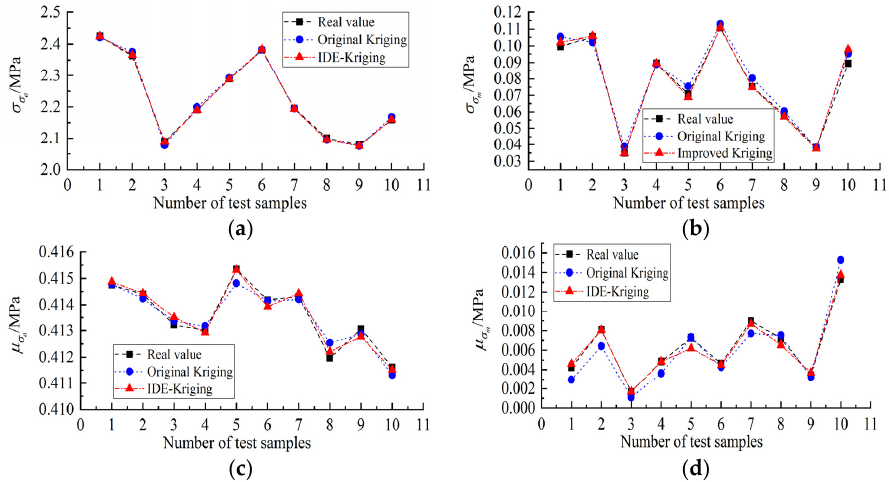
Figure 18. Comparison of prediction results of the second-layer Kriging surrogate model: ( a ) surrogate model of σ σ ; ( b ) surrogate model of σ σ a